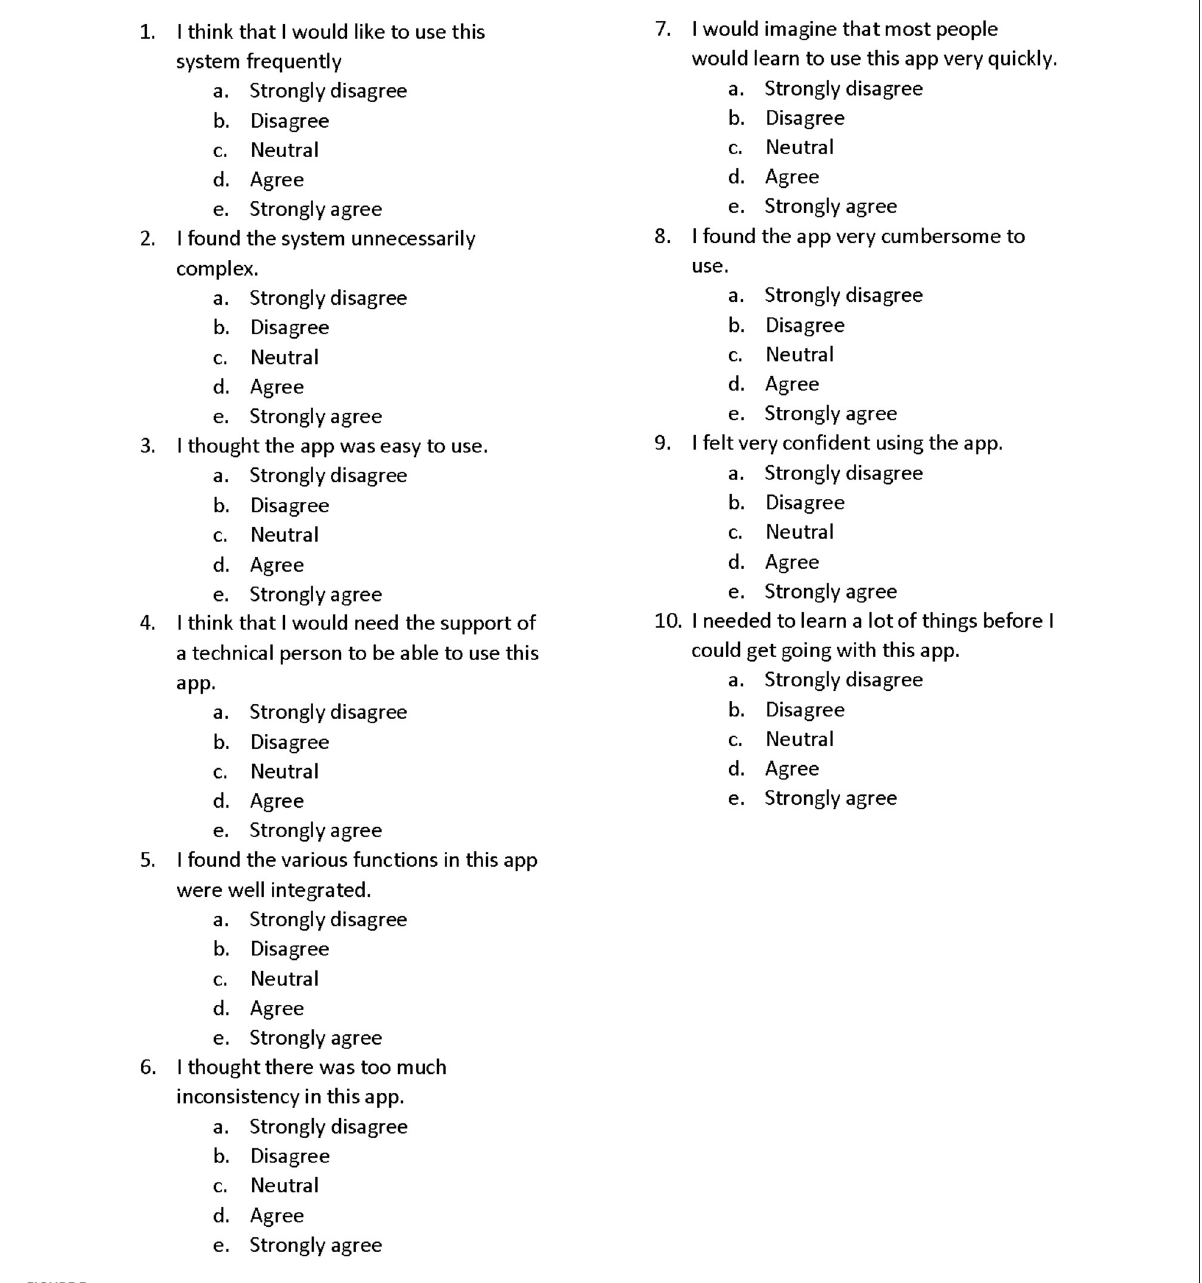
FIGURE3 Systems usability scale